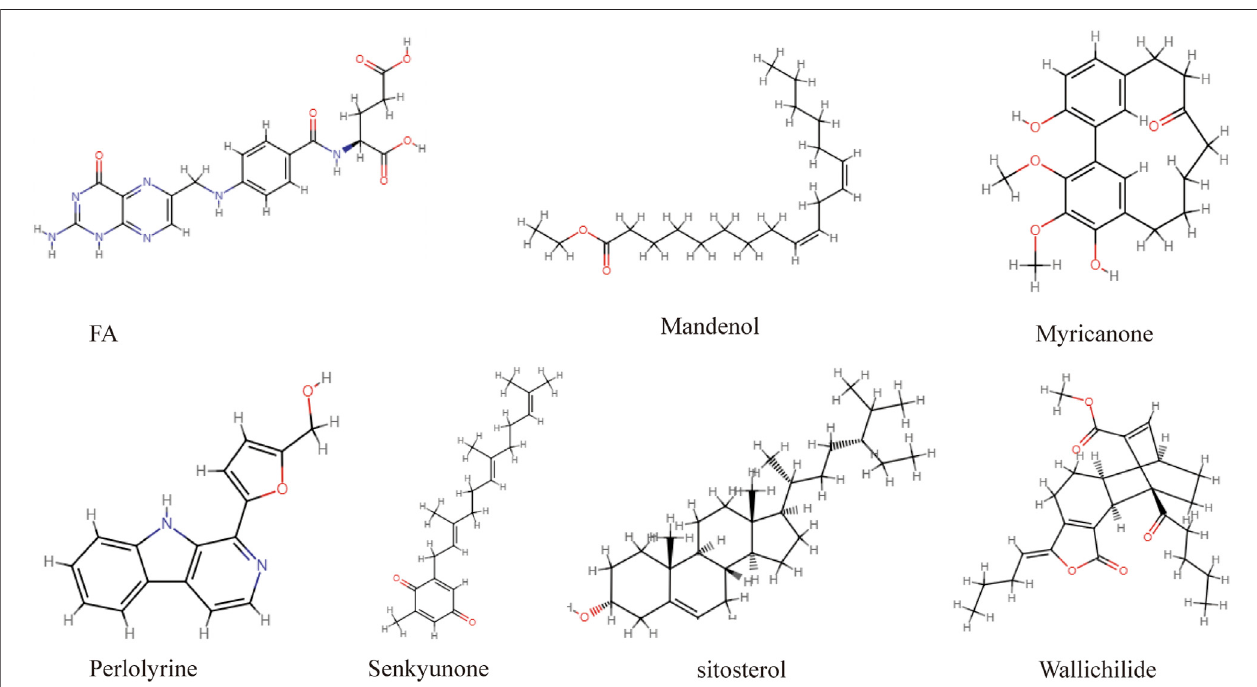
FIGURE 2 | The chemical structure formula of active components of CX screened from the TCMSP database.